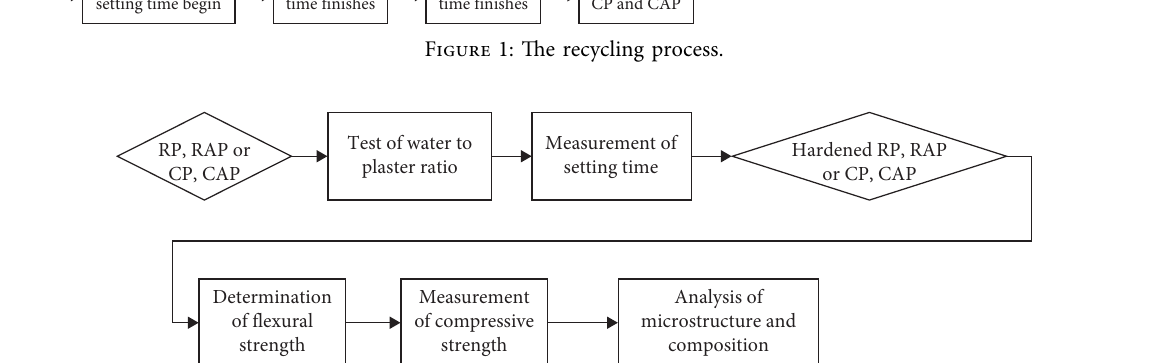
Figure 1: The recycling process.